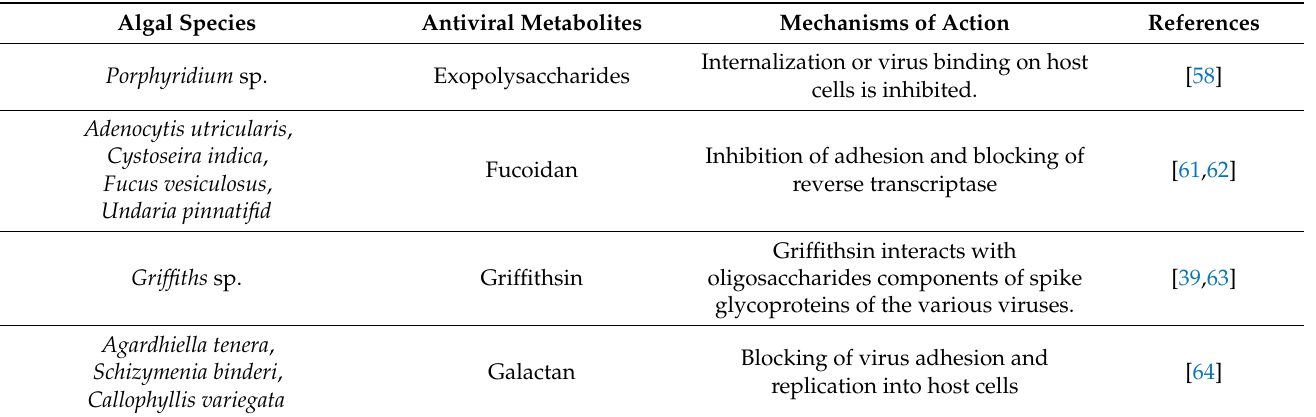
Table 1. List of algae-derived metabolites and their bioactivity as antiviral compounds. Table 1. Cont.